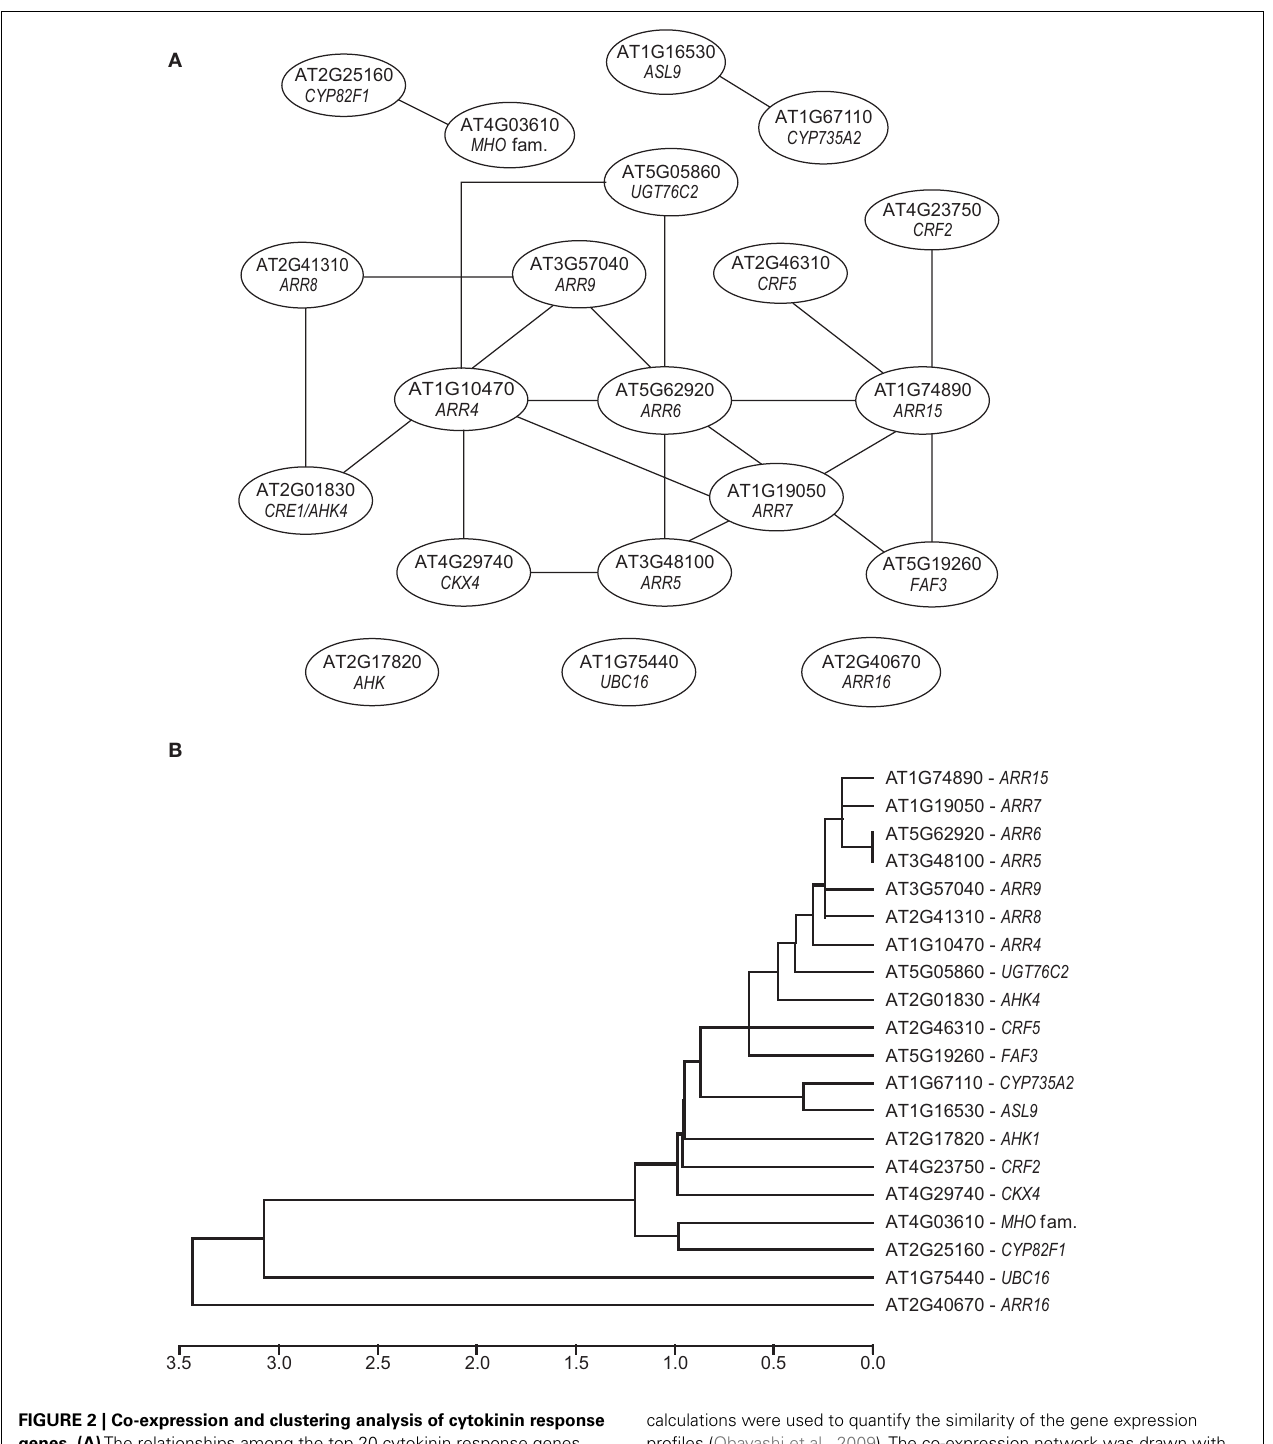
FIGURE 2 | Co-expression and clustering analysis of cytokinin response genes. (A) The relationships among the top 20 cytokinin response genes (see Table 2 ) is visualized by co-expression analysis. For this analysis, expression profiles of the top 20 gene were obtained from 1388